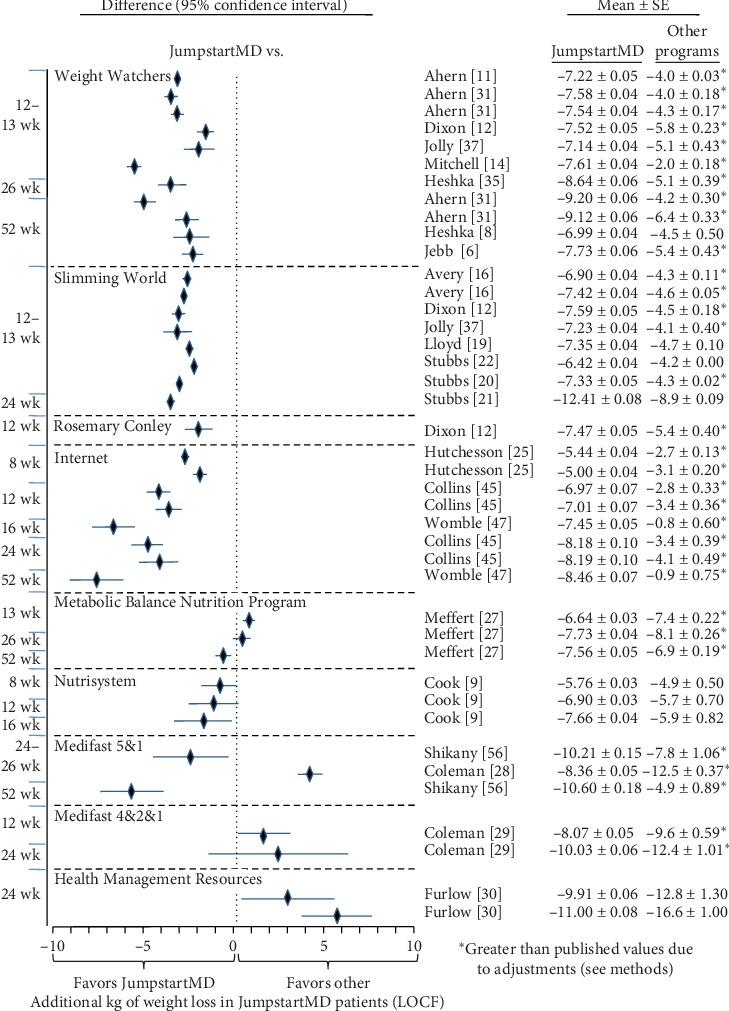
Mean LOCF weight loss difference between JumpstartMD and other commercial programs as measured by Δkg weight loss. Diamonds represent the difference between the adjusted JumpstartMD mean and the other commercial programs, and the horizontal bars represent the corresponding 95% confidence interval for the difference. Negative differences designate greater JumpstartMD weight loss. The time point of the comparison is to the left of the plot. ∗Weight loss in the other commercial programs higher than published value due to adjustment (see Methods). †Mean change ± SE. ‡Mean change ± SEprediction adjusted to the recruitment BMI range and baseline age, proportion of males, and sex-specific BMI effects of the commercial study.